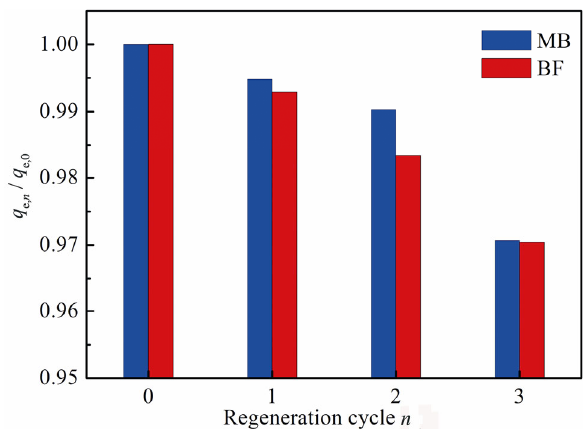
Fig. 13 Regeneration properties of the